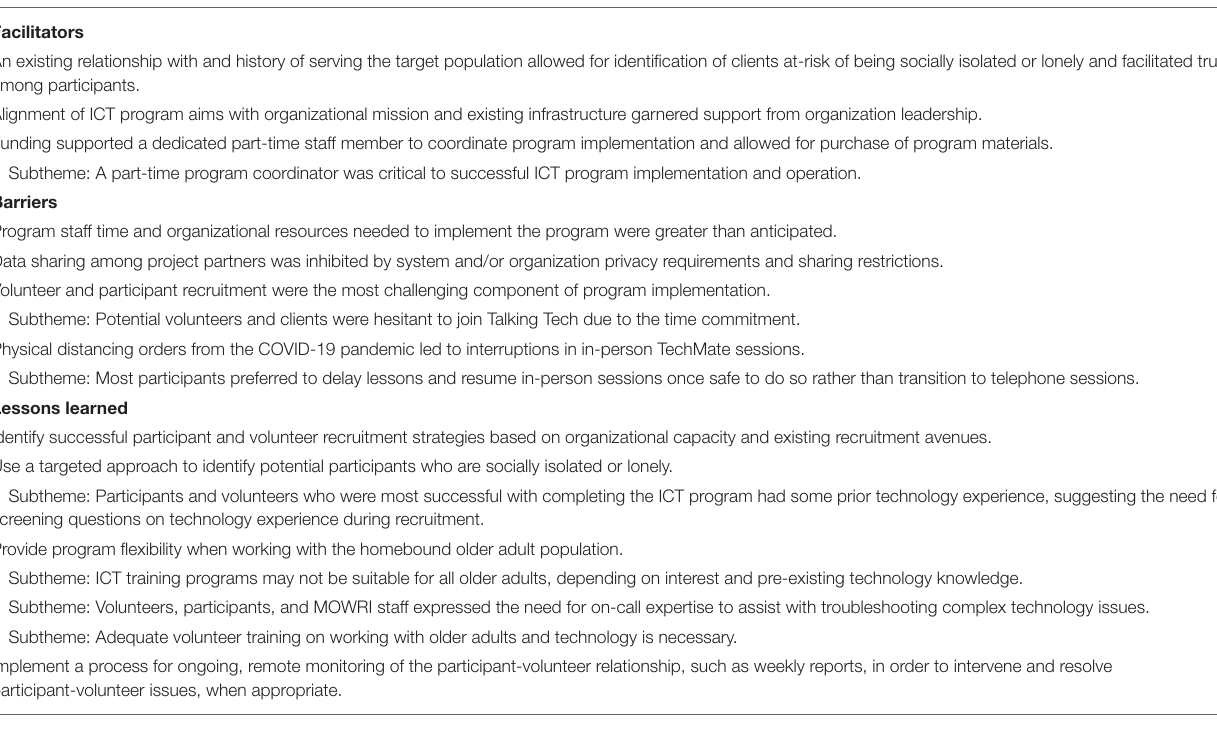
TABLE 2 | Themes of Talking Tech implementation facilitators, barriers, and lessons learned. Theme/Subtheme